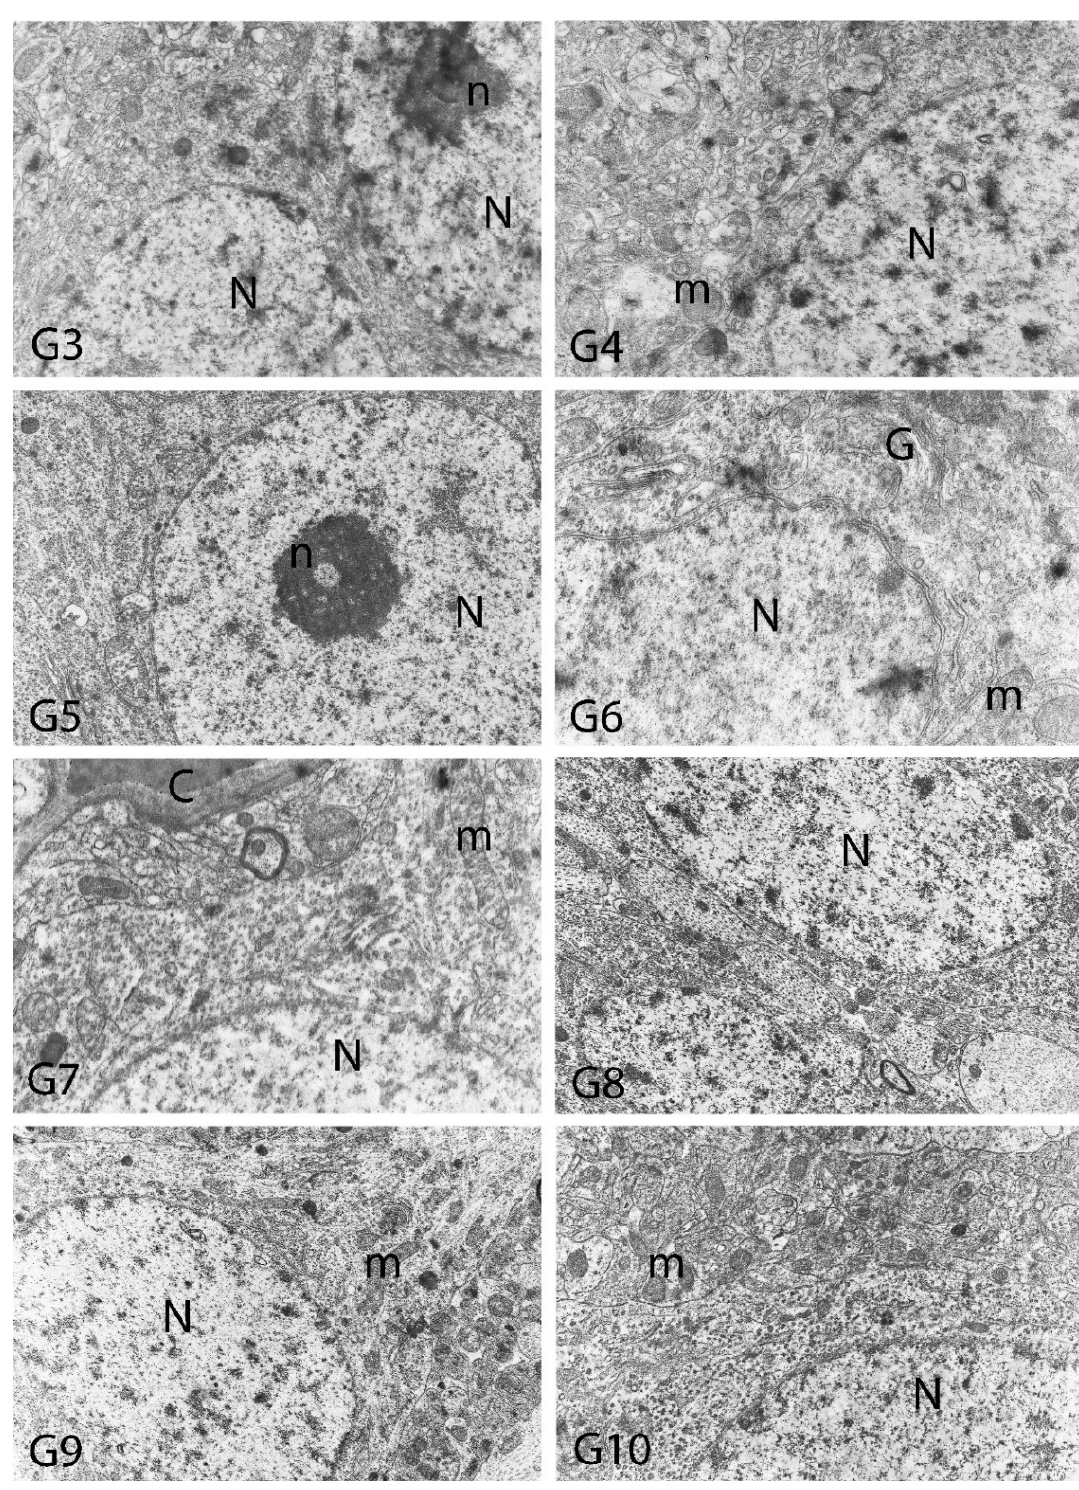
Figure 12. Electron micrographs of rat cerebral cortices from Groups 3 to 10 (G3–G10). N, nucleus; n, nucleolus; C, capillary; m, mitochondria; G, Golgi apparatus. Group definitions are as in Figure 9.